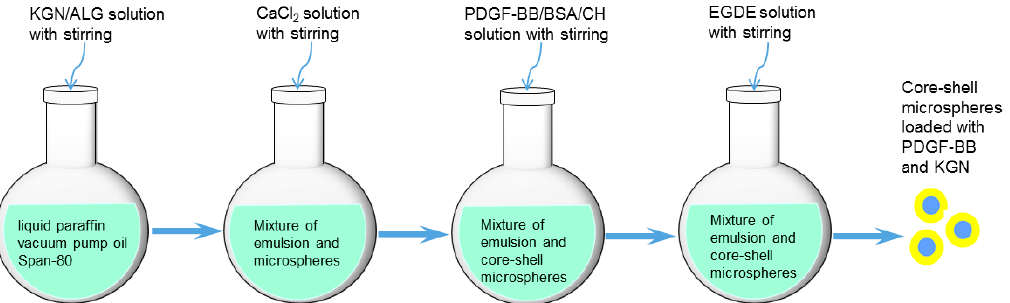
Figure 8. Schematic illustration for preparation of core-shell microspheres loaded with PDGF-BB and KGN.